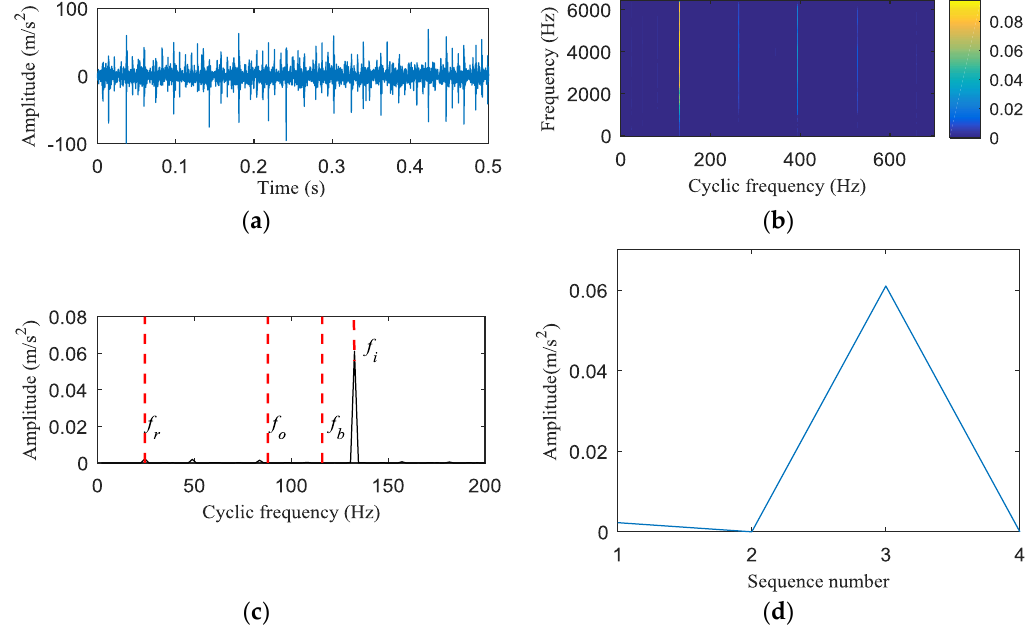
Figure 9. ( a ) The time waveform of an inner-race fault signal; ( b ) the improved fast spectral correlation spectrum; ( c ) the corresponding enhanced envelope spectrum; ( d ) the fault feature vector.